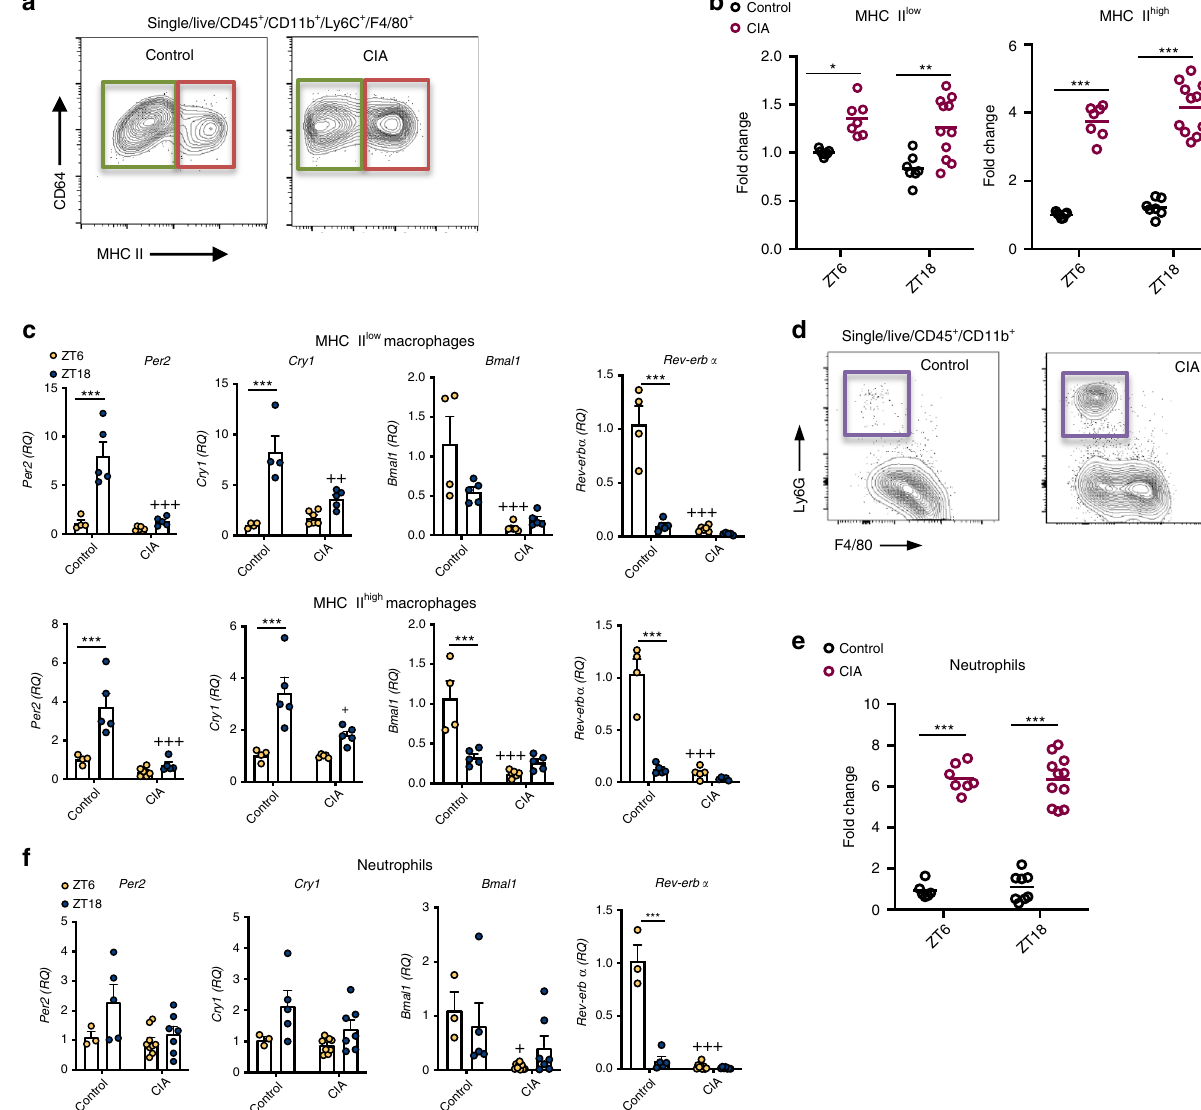
Fig. 1 Macrophage and neutrophil rhythms under chronic in fl ammation. a Two distinct macrophage populations were identi fi ed within joints, MHC II low (green box) and MHC II high (red box). b Numbers of MHC II low and MHCII high macrophages increased within the joints of arthritic animals, neither showed any time-of-day variation in numbers under control or arthritic conditions, data pooled from two separate experiments and normalised to control ZT6 mice (ZT6: control n = 7; CIA n = 7; ZT18: control n = 7; CIA n = 11), two-way ANOVA and Bonferonni post hoc tests. Graphs show individual data points with mean values. c MHC II low and MHC II high macrophages sorted from joints at ZT6 (control n = 4; CIA n = 6) or ZT18 (control n = 5; CIA n = 5) were analysed for clock gene expression (normalised to gapdh ), data normalised to control ZT6, two-way ANOVA and post-hoc Bonferonni. Data are presented as mean values± SEM. d Representative fl ow cytometry plots showing abundant neutrophil in fi ltration into the joints in CIA. e Numbers of neutrophils increased within the joints of arthritic animals, but did not show time-of-day variation in numbers under control or arthritic conditions, data pooled from two separate experiments and normalised to control ZT6 mice (ZT6: control n = 6; CIA n = 9; ZT18: control n = 8; CIA n = 11), two-way ANOVA and Bonferonni post hoc tests. Graph shows individual data points with mean values. f Clock gene expression (normalised to gapdh ) in neutrophils sorted from joints at ZT6 (control n = 3; CIA n = 9) and ZT18 (control n = 5; CIA n = 7), data normalised to control ZT6, two-way ANOVA and post-hoc Bonferonni. Data are presented as mean values ± SEM. In all panels statistical signi fi cance between timepoints is shown as * p < 0.05, ** p < 0.01 and *** p < 0.005 and signi fi cant statistical differences between treatment at given timepoints as + p < 0.05, ++ p < 0.01 and +++ p < 0.005. Source data are provided as a Source Data fi